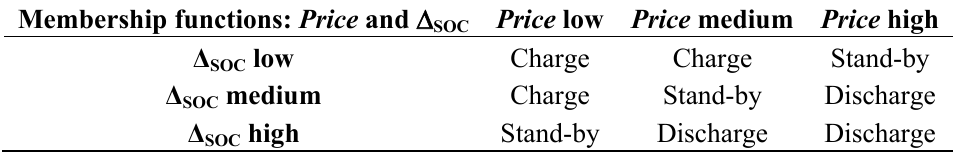
Table 1. Fuzzy rules for the energy storage systems (ESS) charge